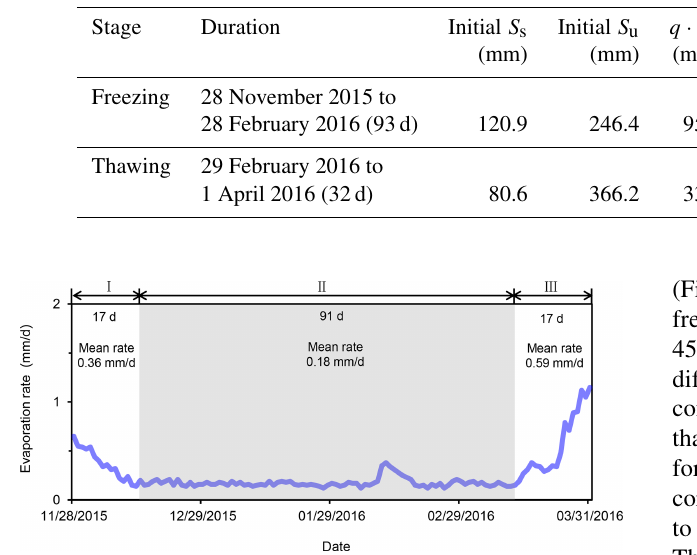
Figure 7. The simulated daily soil evaporation rate at the field site. Also shown are the mean evaporation rates for the three stages with different trends of daily soil evaporation